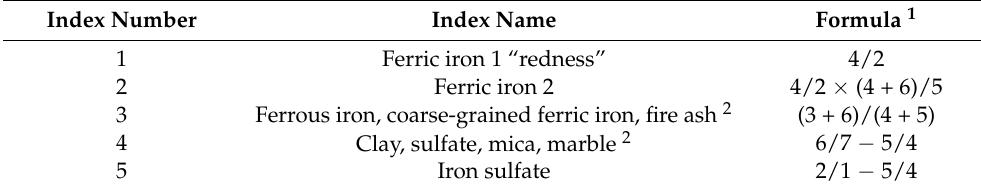
Table 1. Landsat 8 OLI band ratios from Rockwell et al. [36] used to characterize iron-bearing and alteration minerals.